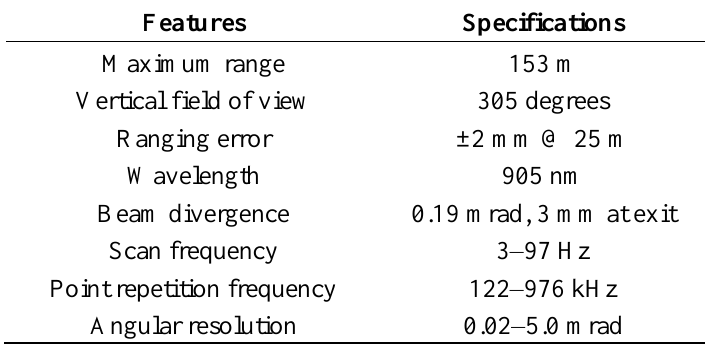
Table 2. Specifications of the laser scanner (FARO Focus3D 120 a